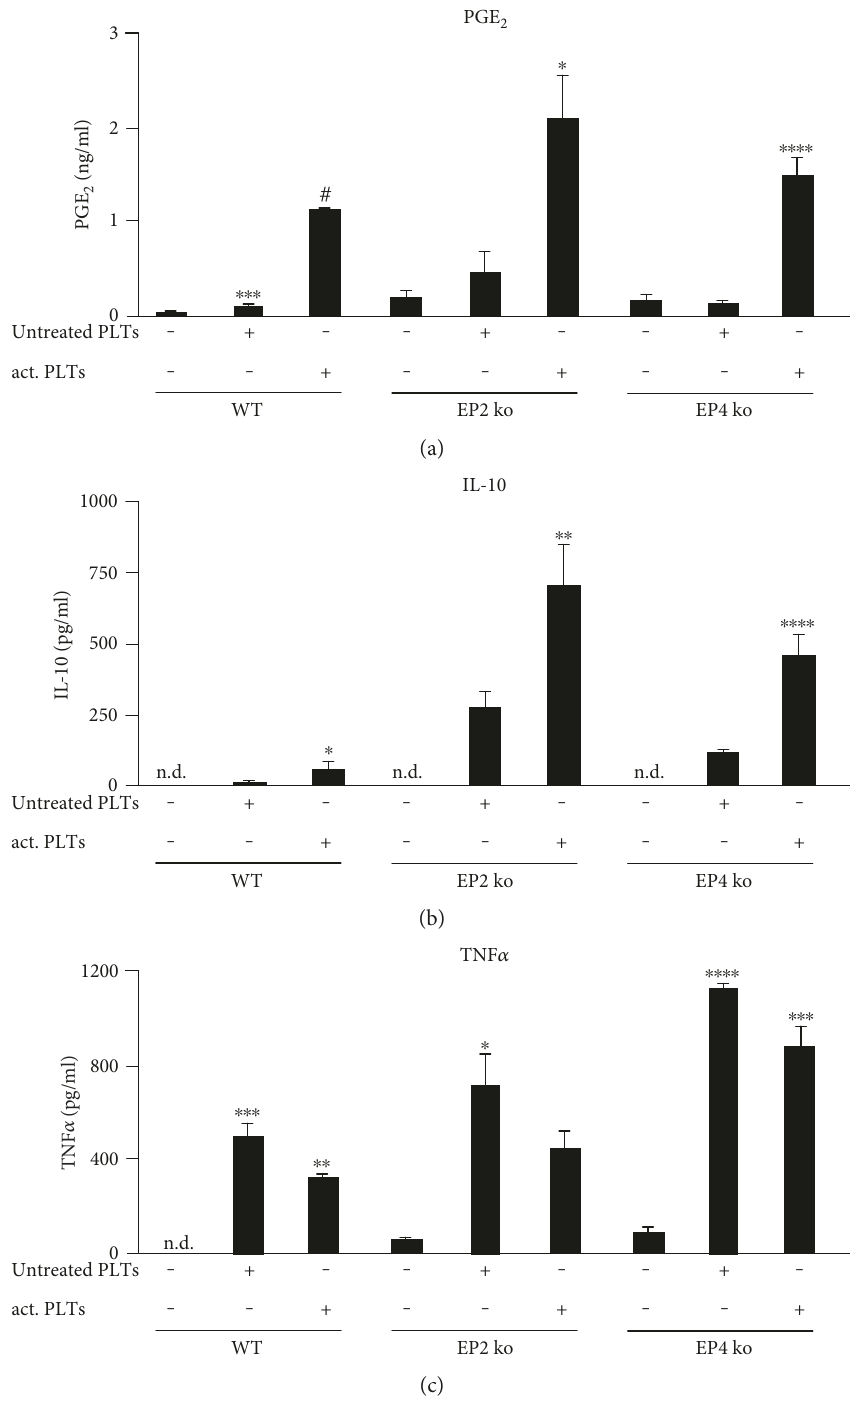
Figure 5: Ex vivo validation of the cross-regulation between platelet PGE macrophages. Murine BMDM from wild-type, EP2-de fi cient, and EP4-de fi cient mice were incubated alone, with untreated platelets (untreated PLTs) or with platelets prestimulated with collagen (1 μ g/ml; act. PLTs) for 3 hours. The concentrations of PGE determined by LC-MS/MS. IL-10 levels (b) and TNF α levels (c) were determined by ELISA. One-way ANOVA/Bonferroni ∗ P < 0 05 , ∗∗ P < 0 01 , ∗∗∗ P < 0 002 , ∗∗∗∗ P < 0 0004 , # <